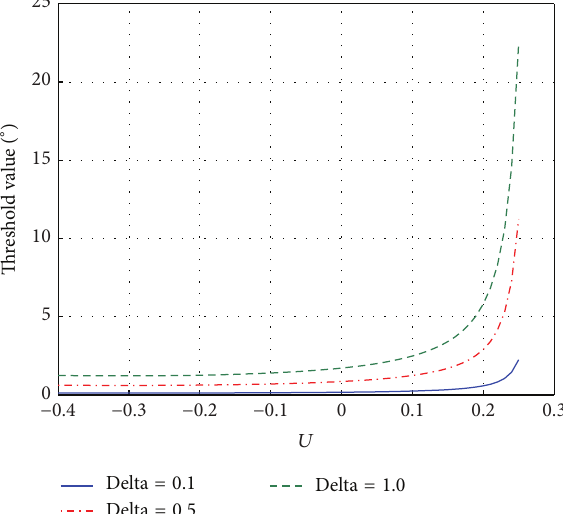
Figure 9: Threshold value for different values of 𝑢